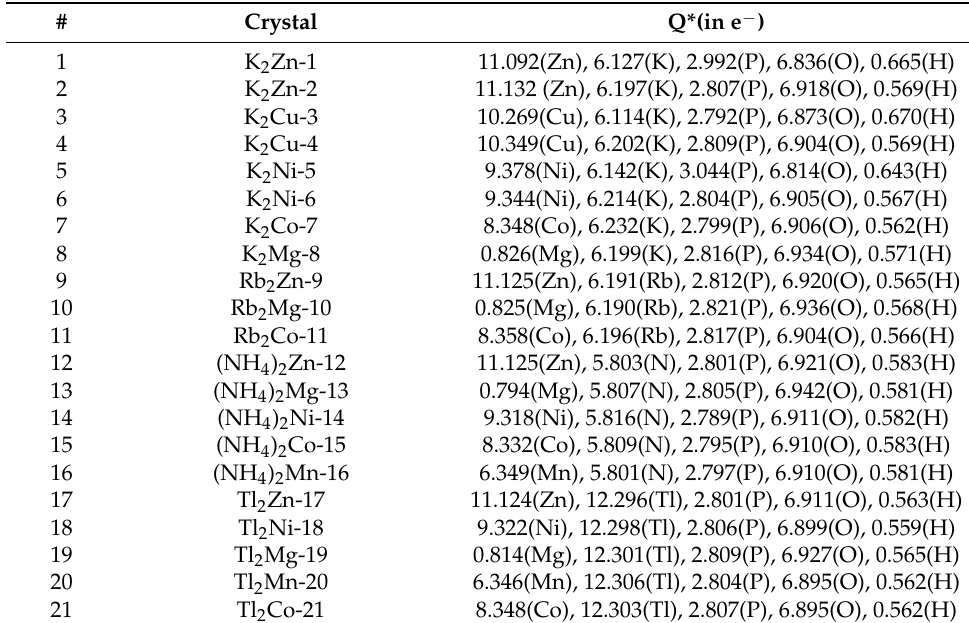
Figure 3. Distribution of calculated BO vs. BL for crystals from 3 to 6. Table 3. Effective charge (Q*) for each atom in the 21